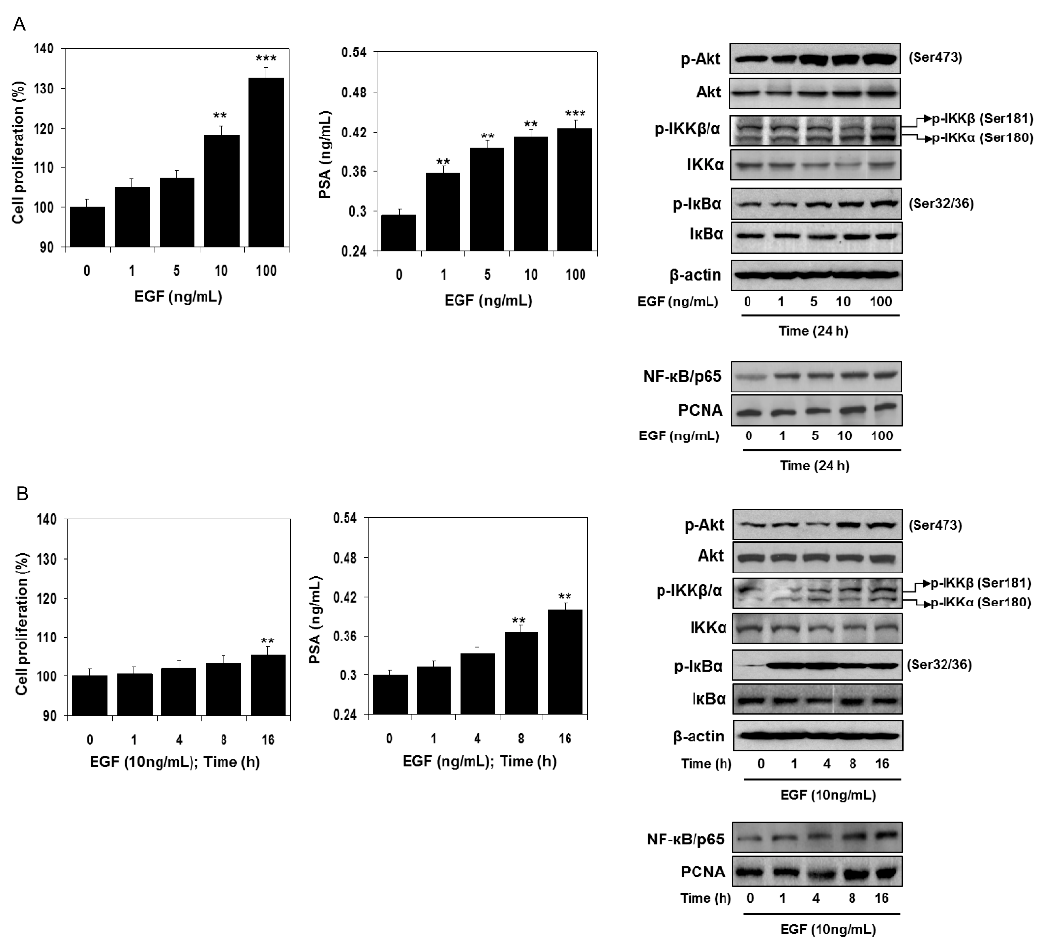
Figure 5. Effect of EGF treatment to RWPE1 cells in an ( A ) dose- and ( B ) time-dependent manner. RWPE1 cells were subjected to EGF exposure at doses between 1 to 100 ng/mL, and for time-dependent studies 10 ng/mL EGF was used. Cell proliferation was assessed by MTT assay and PSA by ELISA assay. Columns represent mean ± SD of three independent assays. ** p < 0.05 versus control. *** p < 0.001 versus control. Western blots for p-Akt (Ser473), Akt, p-IKK α / β , IKK α , p-I κ B α , and I κ B α in the total cell lysate and NF- κ B/p65 in the nuclear fraction of RWPE1 cells after EGF exposure in a dose- and time-dependent manner. β -actin and PCNA were used as internal loading controls. Details are provided in the Materials and Methods section.